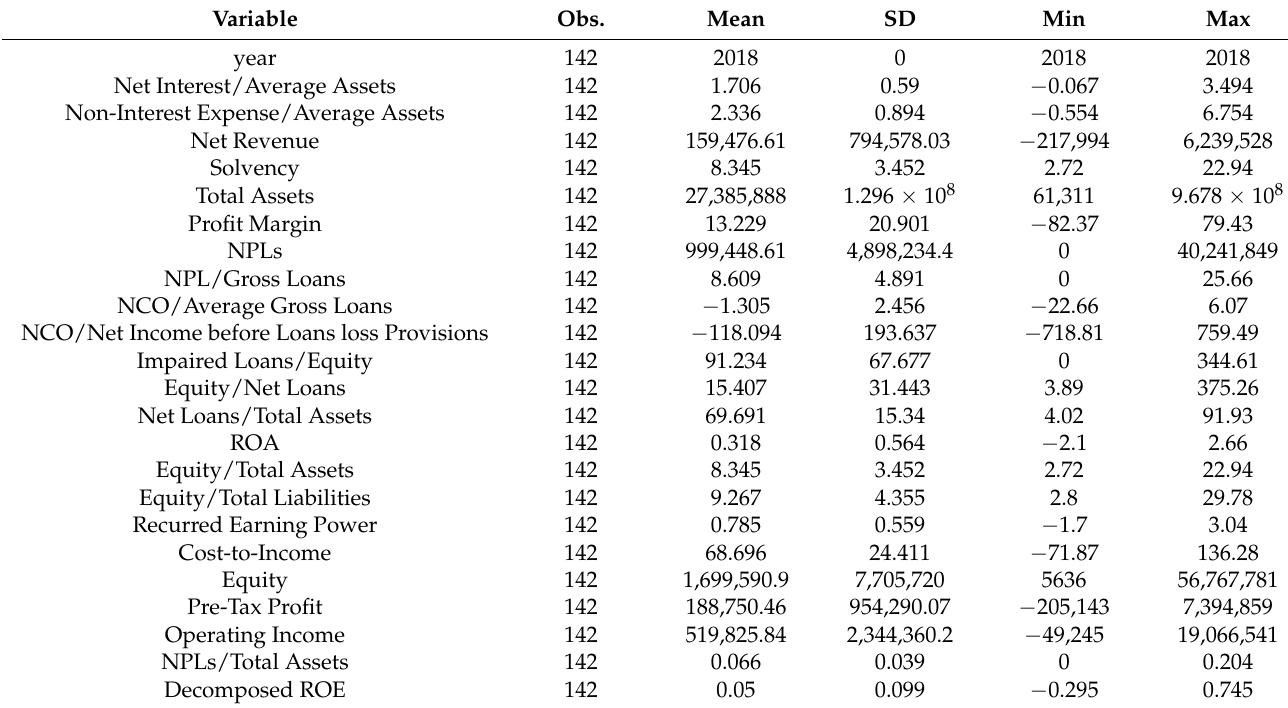
Table A8. Descriptive statistics for the 142 Italian banks for the year